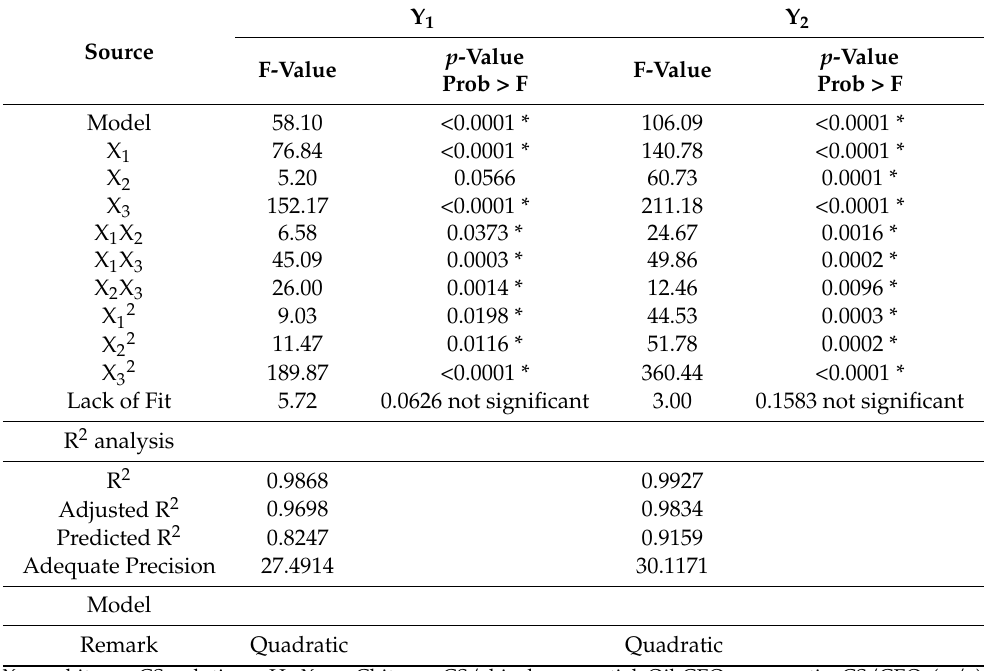
Table 2. Adequacy of the model and model summary statistics for encapsulation efficiency and loading capacity.